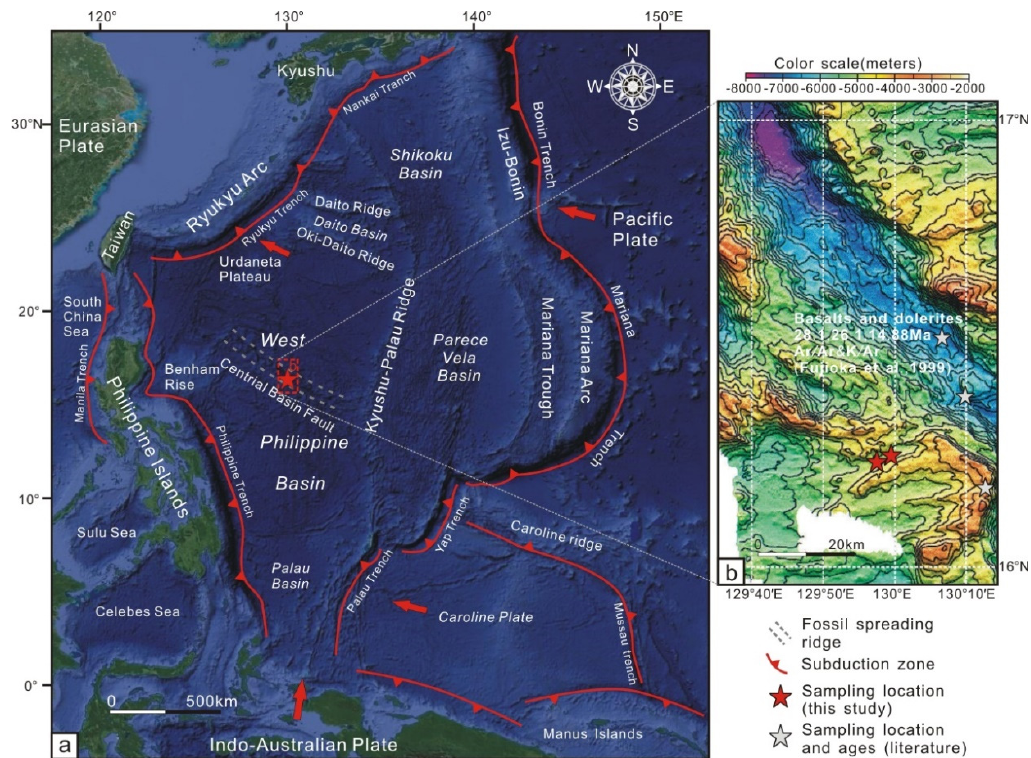
Figure 1. ( a ) Schematic tectonic framework of the Philippine Plate showing major tectonic subdivisions (modified after Reference [18]). ( b ) Geomorphological–bathymetric map illustrating the survey area (modified after Reference [22]). A gray star represents previously dated pillow lava [7]. The sample sites for this work are also marked by a red star.